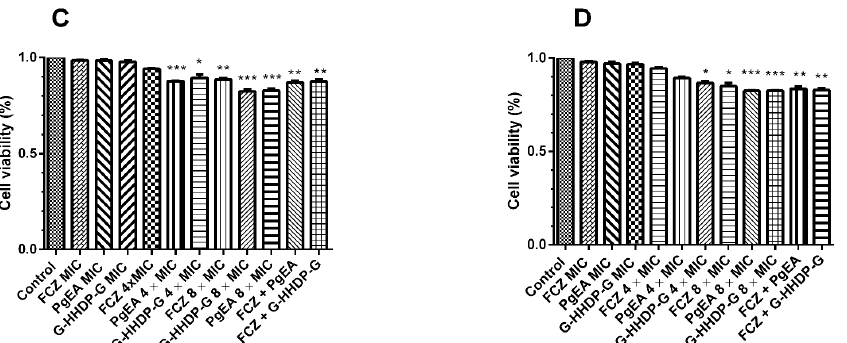
Figure 3. Effect of the ethyl acetate fraction of P. granatum (PgEA), galloyl-HHDP-glucose (G-HHDP-G), and Fluconazole (FCZ) on preformed biofilms of Candida spp. ( A ) Effect of PgEA and FCZ on the preformed biofilm of the reference strain C. albicans 90028, using inhibitory, higher than inhibitory, and synergistic concentrations. ( B ) Effect of PgEA and FCZ on the preformed biofilm of the isolate of clinical C. albicans CAS, using inhibitory, higher than inhibitory, and synergistic concentrations. ( C ) Effect of PgEA, G-HHDP-G, and FCZ on the preformed biofilm of the reference strain C. glabrata 2001, using inhibitory, higher than inhibitory, and synergistic concentrations. ( D ) Effect of PgEA, G-HHDP-G, and FCZ on the preformed biofilm of the clinical isolate C. glabrata FJF, using inhibitory, higher than inhibitory, and synergistic concentrations. * p < 0.05, ** p < 0.01, and *** p < 0.0001. Data represent the mean ± SD of three independent experiments carried out in triplicate.